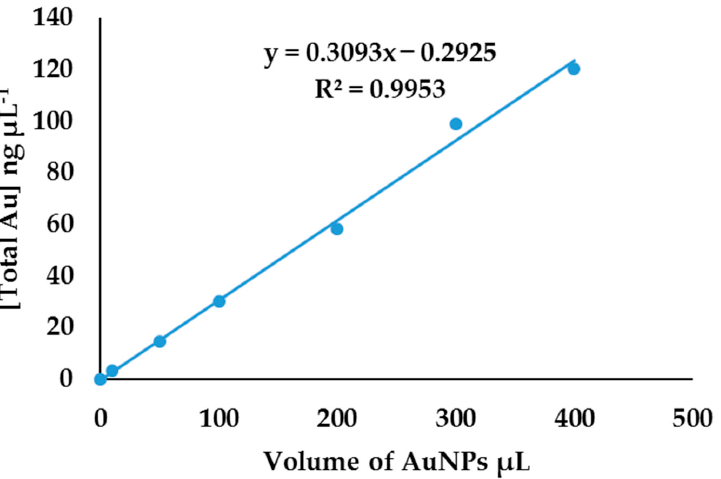
Figure 8. Relationship between the total concentration of AuNPs and AuNPs’ volume spiked in soil